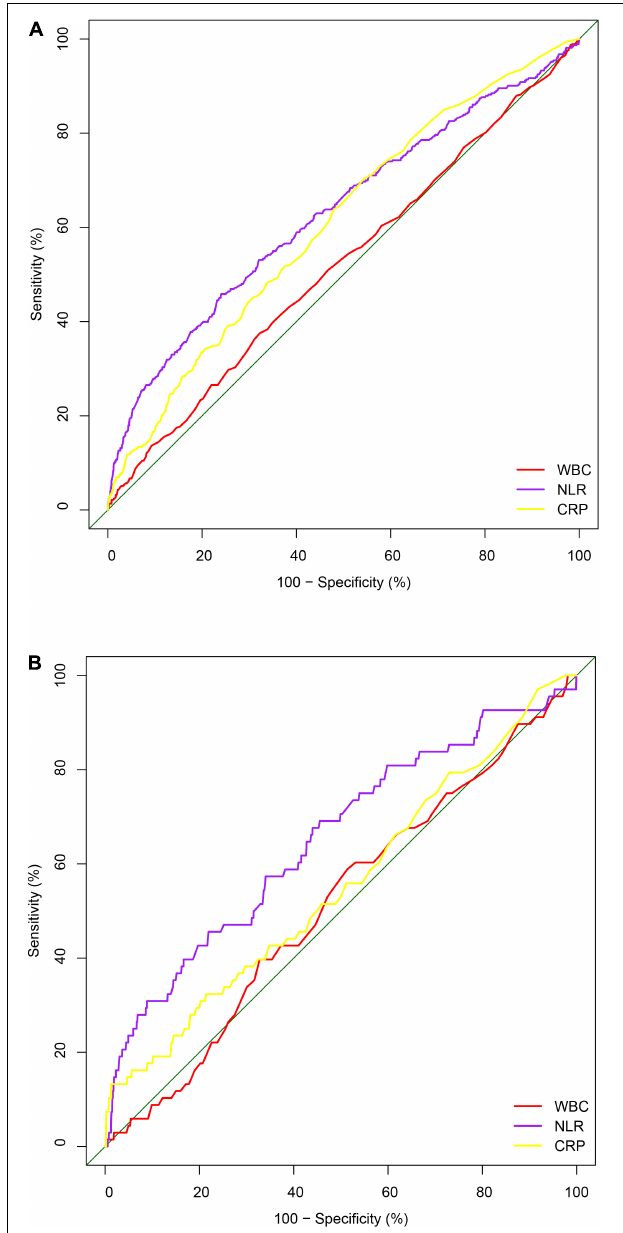
FIGURE 4 | (A) ROC curve analysis of NLR, compared to CRP and WBC to predict all-cause mortality. (B) ROC curve analysis of NLR, compared to CRP and WBC to predict cardiovascular mortality. CRP, C-reactive protein (mg/dl); WBC, white blood cell count in CBC ( × 10 9 /L).